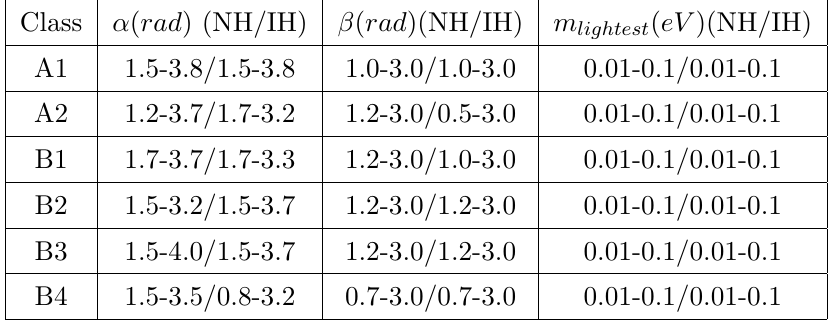
Table 9 . The range of parameters ( (cid:11); (cid:12) and m lightest ) that satis(cid:12)es the KamLAND-Zen limit of e(cid:11)ective Majorana neutrino mass.